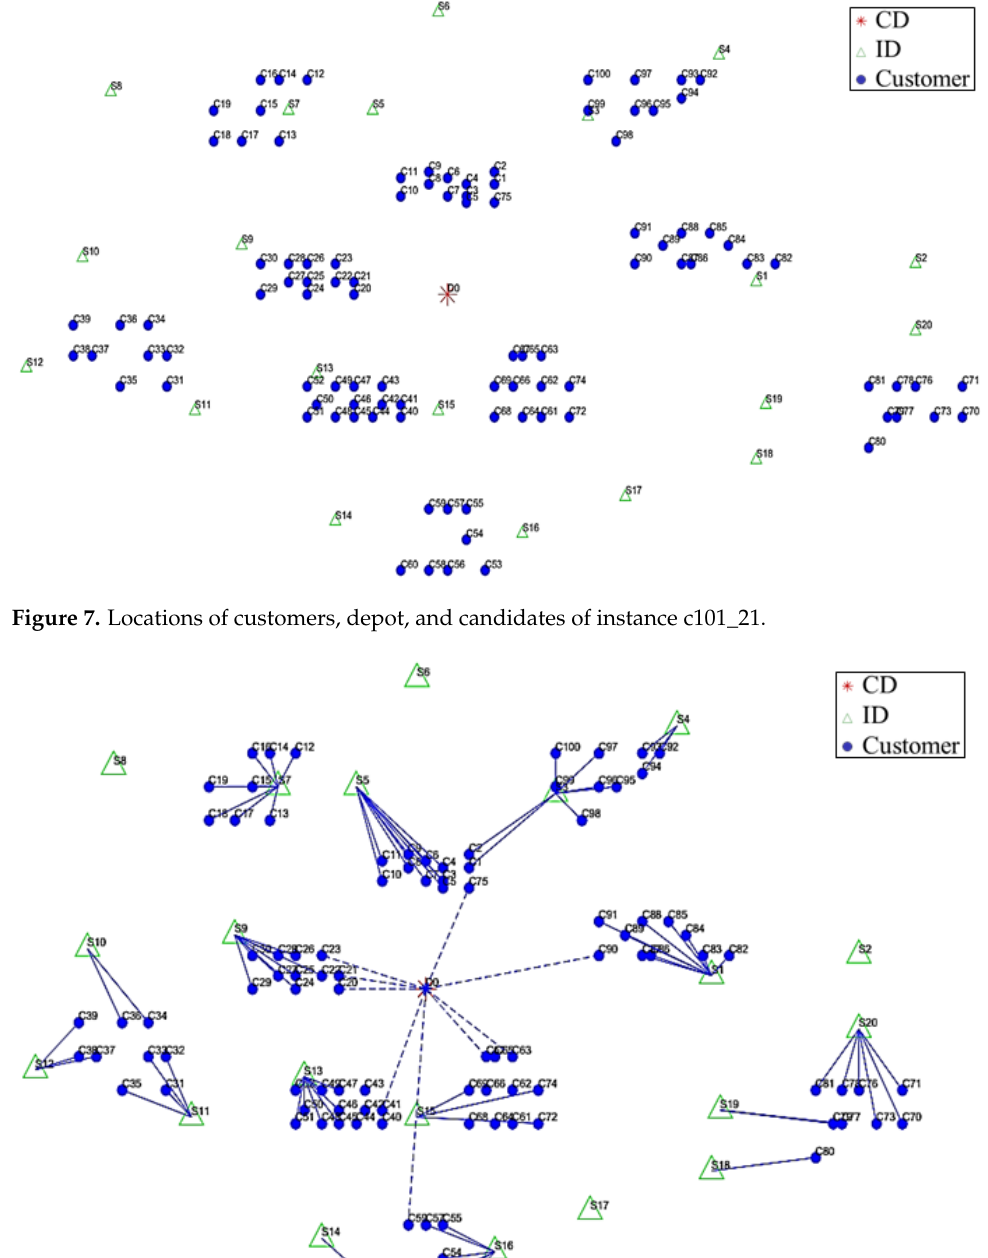
Figure 8. Initial customer clustering with the default range of EVs. As shown in Figure 8, customers connected to CD, i.e., 𝐷 0 , with dash lines are the outliners that are served by CVs from CD, and a total of 9 out of 100 customers are